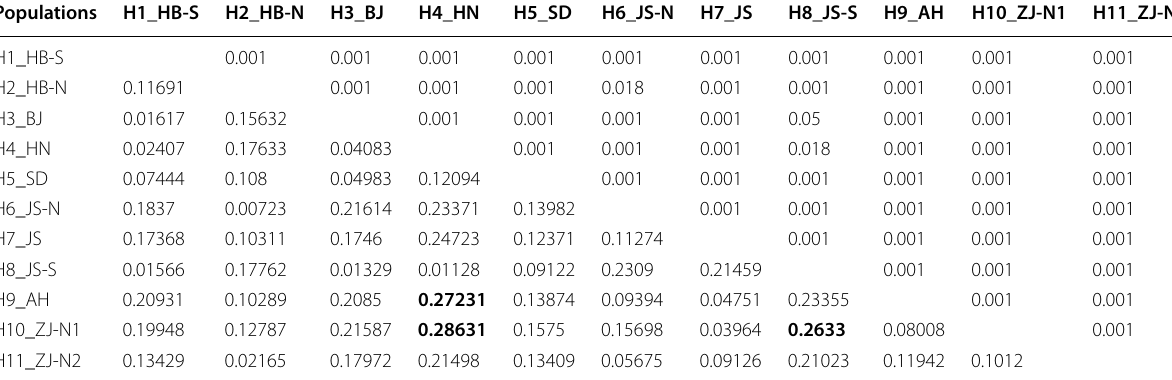
Table 5 F values for pairwise populations revealed a moderate level of genetic differentiation ST